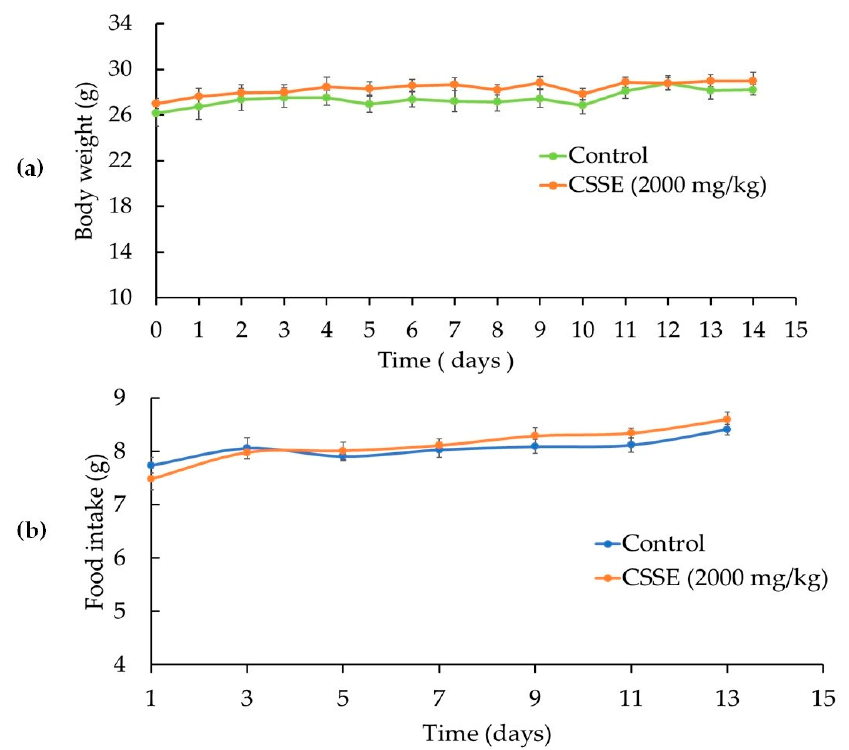
Figure 1. Evolution of the body weight ( a ) and the food intake ( b ) of mice treated with a single dose of CSSE (2000 mg/kg, p.o.). CSSE: C. sativus stigma extract. The values are expressed as mean ± SEM ( n = 6). No significant difference was recorded between CSSE-treated group and non-treated control ( p < 0.05, ANOVA I Tukey’s test). Table 2. The relative organ weight of mice treated with a single oral dose of CSSE. Organ